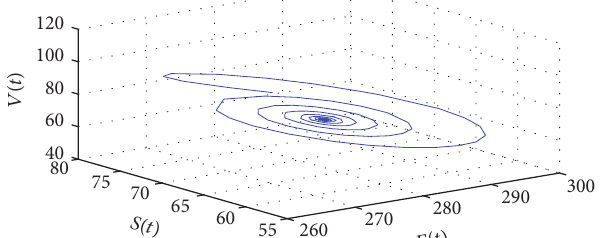
Figure 13: The projection of the phase portrait of system (69) in (𝑆, 𝐸,𝑉) -space with 𝜏